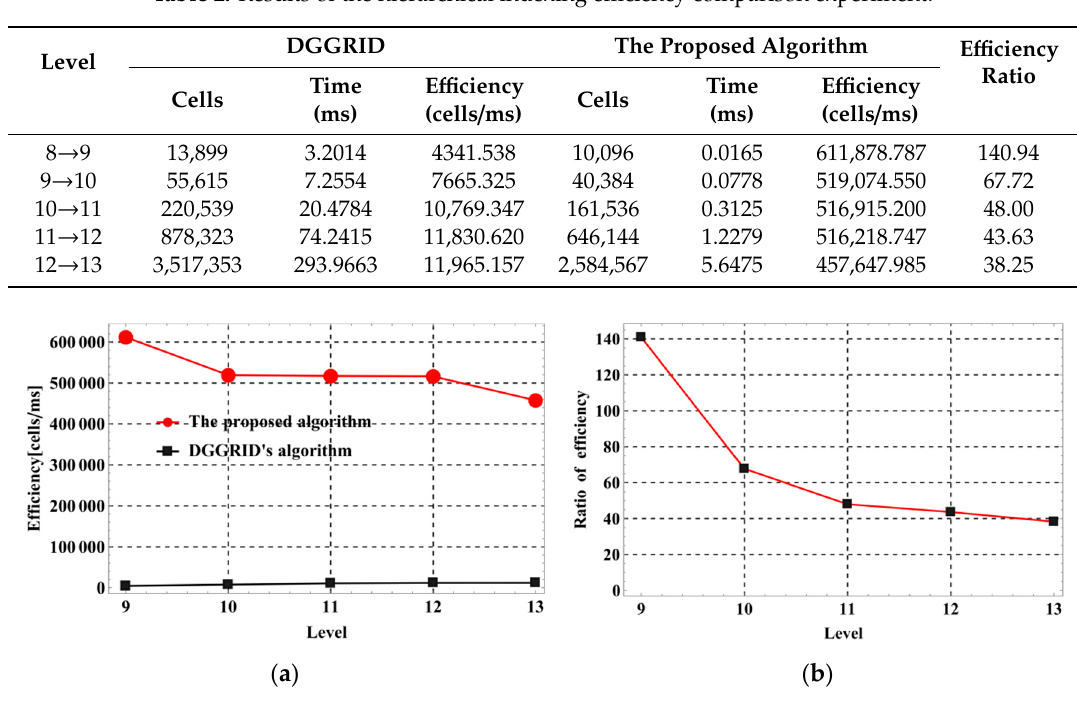
Figure 12. Efficiency comparison line chart for hierarchical indexing: ( a ) absolute value and ( b ) ratio.